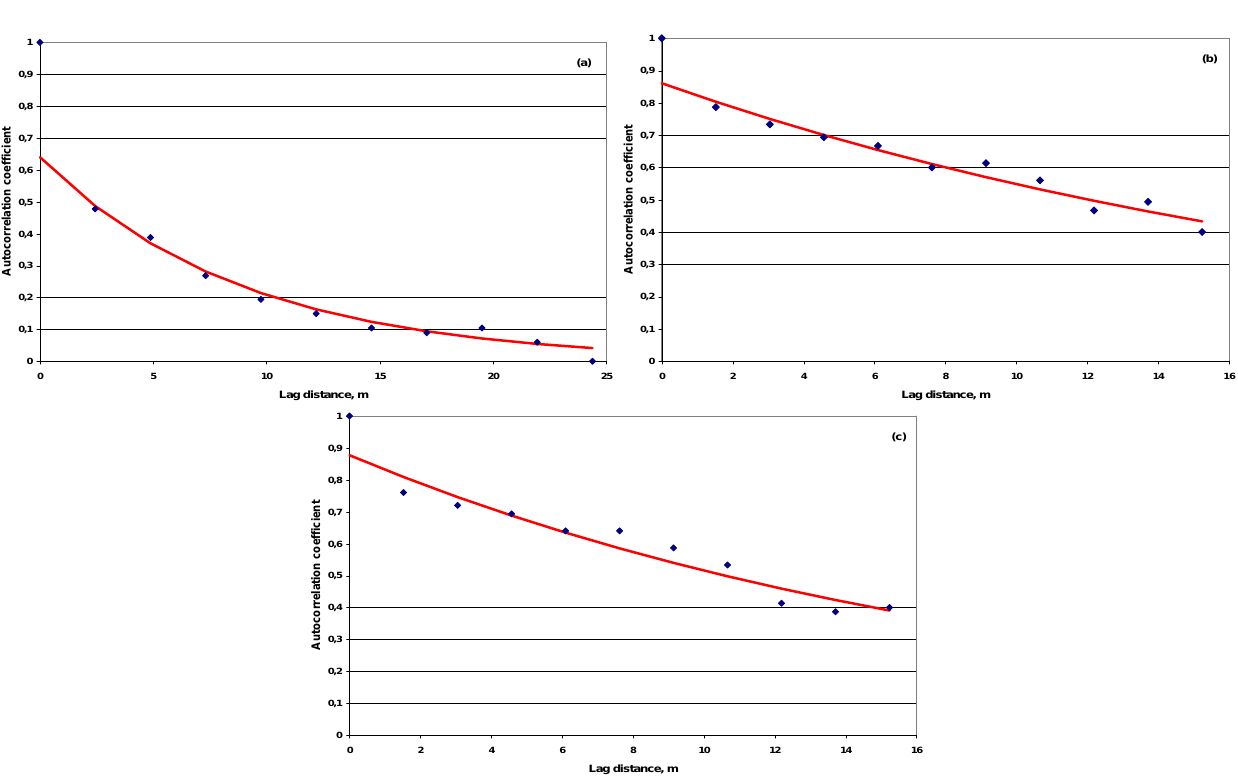
Fig. 6. Estimated autocorrelation coefficients (blue diamonds) and best-fitting negative exponential autocorrelation functions (red curves) derived from logarithmically transformed element concentration values: (a) Average of correlograms for 24 channel sample series from drifts at various levels of Whalesback copper deposit, Newfoundland (after Agterberg, 1974); (b) Series of 462 gold assays from the Orange Free State Mine, Witwatersrand goldfields, South Africa (modified from Krige et al., 1969); (c) Other series of 540 gold assays from same gold mine. In each diagram the fitted exponential (red line) intersects the vertical axis at a point with autocorrelation coefficient less than 1 indicating the existence of a nugget effect.